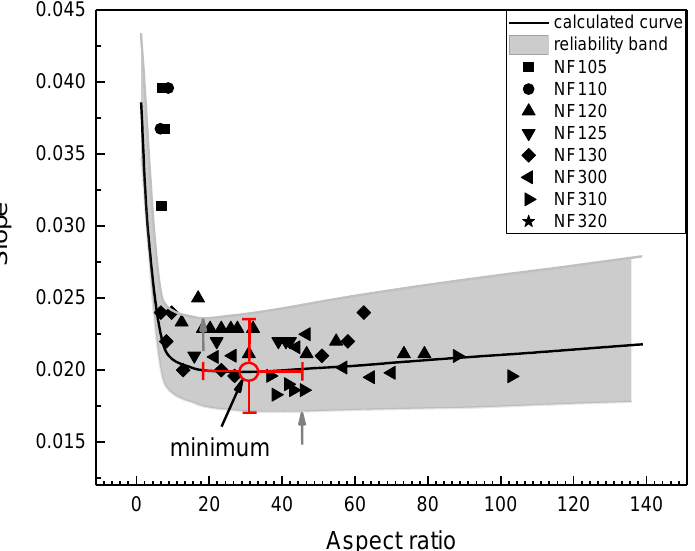
Figure 9. The calculation results and reliability band of Equation (4) compared with the measured data.